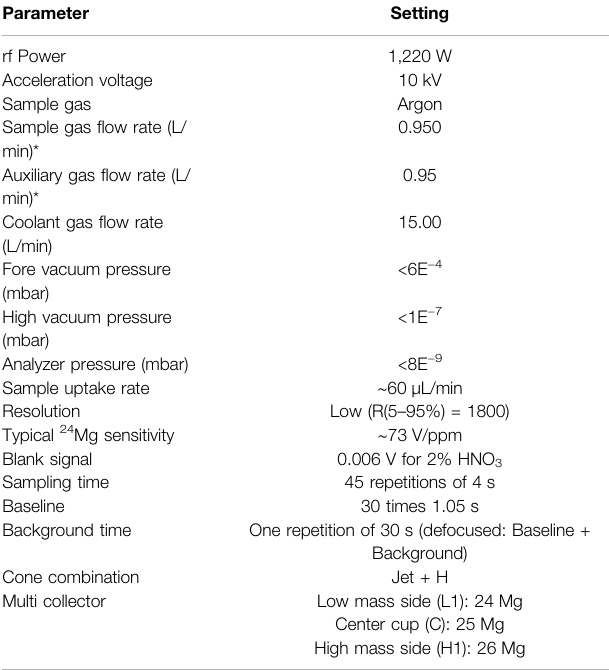
TABLE 2 | Summary of analytical details used during measurements at